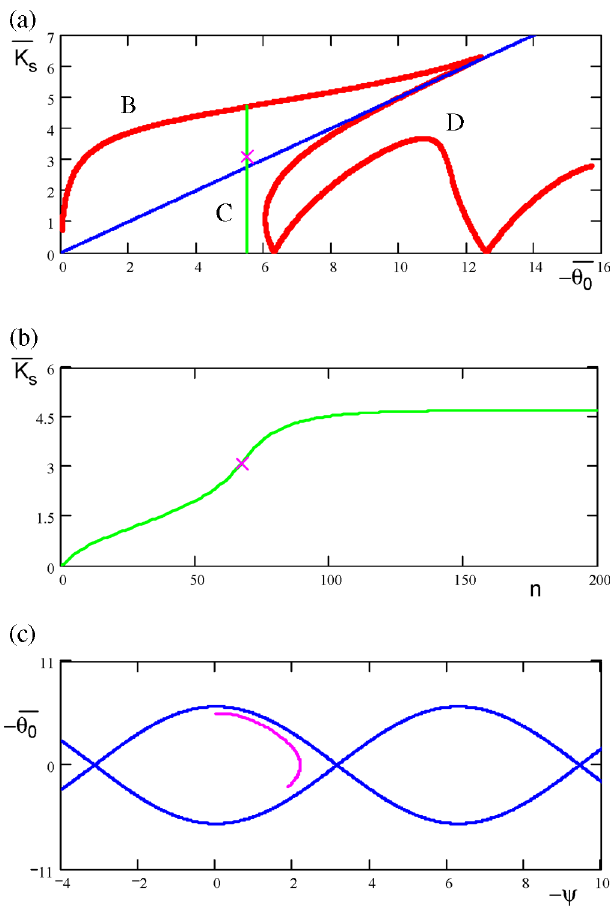
VIDEO 1. Dynamics of oscillation buildup in a stimulated-